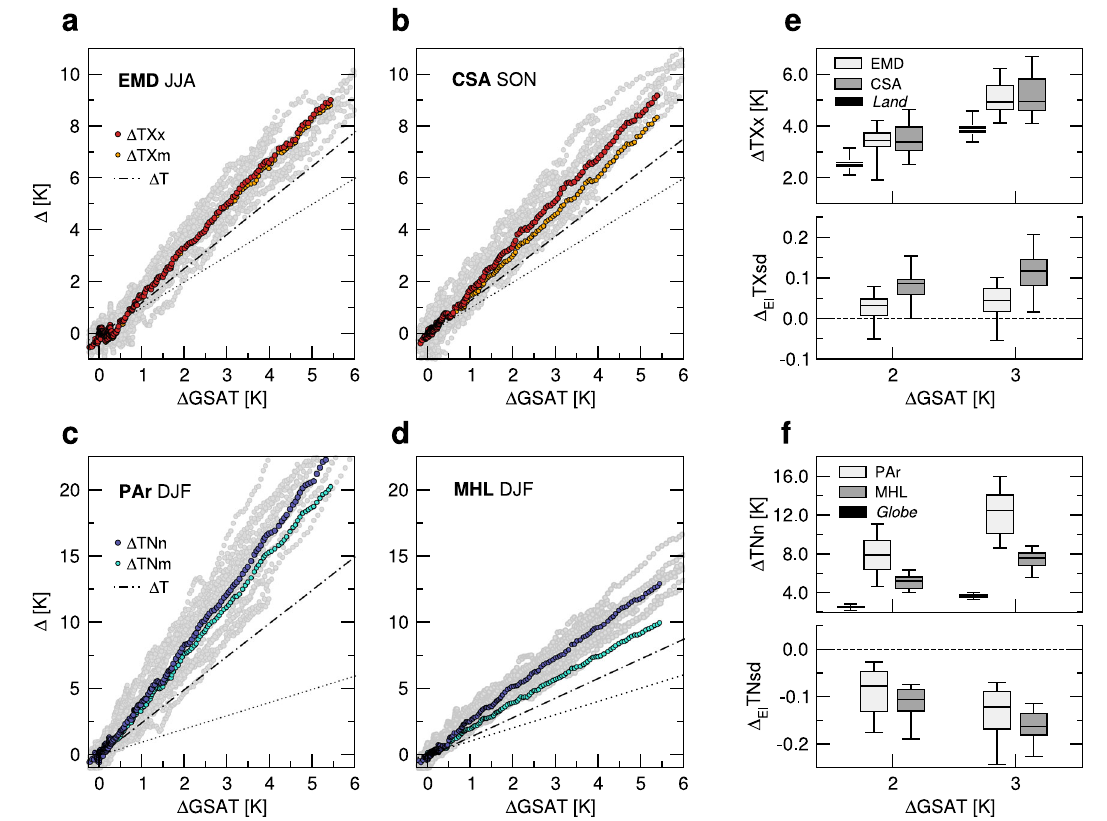
averages ( Δ T , given by straight-line fi ts). Dotted lines denote the identity relation. e , f Top panels: distribution of TXx and TNn changes across model projections at +2K and +3K warming, for the above-de fi ned regions. Annual changes in land averaged TXx andglobal TNn arealsoshownin e and f ,respectively.Bottompanels: distribution of fractional changes in standard deviation e TXsd and f TNsd across models, for the same regions and warming levels as above. Box-plots display the fi ve-number summary statistics (as in Fig. 1a). All changes are referenced to early industrial times and based on the high-end scenario